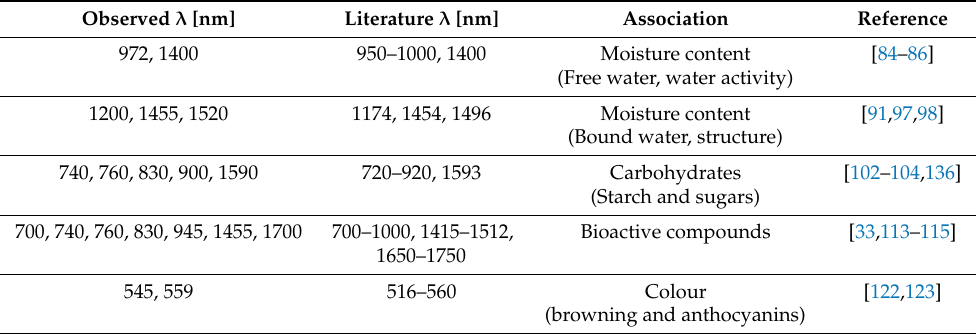
Table 8. Summary of spectral analysis